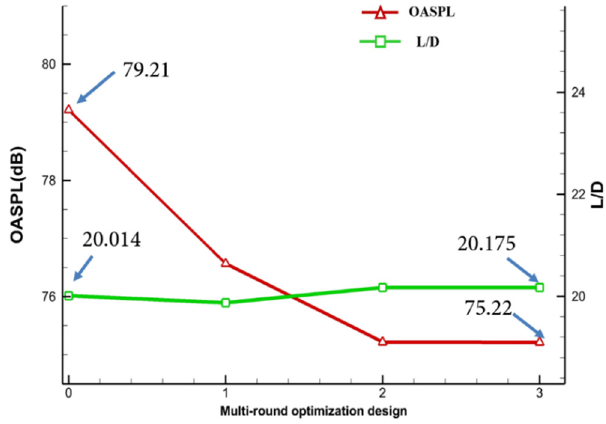
Figure 20. Converging process of optimization objectives.